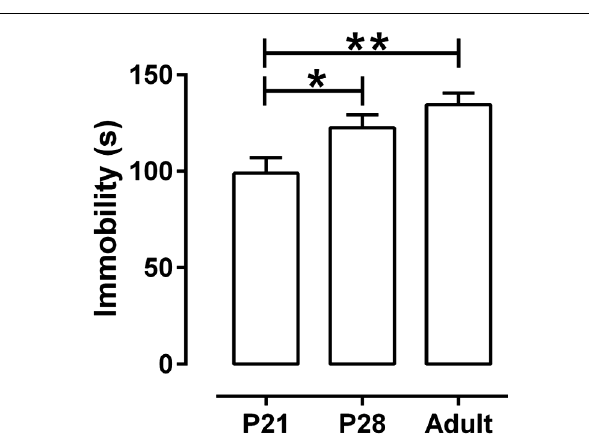
FIGURE 1 | Immobility time in theTST as a function of age. Juvenile mice (P21) spent significantly less time immobile than either adolescent (P28) or adult mice ( P > 62). Each age group consisted of 40 animals treated with saline (20 males and 20 females, half of them treated sc and the other half ip). Because there were neither main nor interaction effects of gender and route of administration, data are shown collapsed with age as the only factor. *P < 0.05, **P < 0.01 (Tukey post hoc test). Data are mean and SEM.